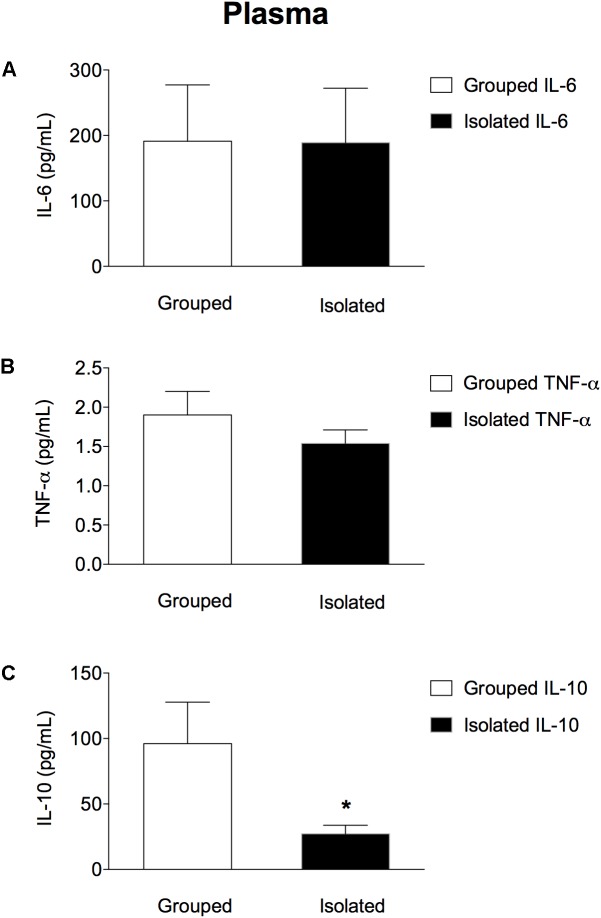
Effect of rearing condition (isolated vs. grouped) on cytokines plasma levels of rats exposed to 10 weeks of social isolation. No difference was found for (A) IL-6 or (B) TNF-α plasma concentration in isolated rats (n = 10) when compared to grouped housed (n = 9). However, isolated rats (n = 10) showed lower (C) IL-10 plasma concentration when compared to grouped-housed (n = 9). Data are expressed as mean ± S.E.M and given as pg/mL. ∗p < 0.05 (Student’s t-test) compared to grouped rats.